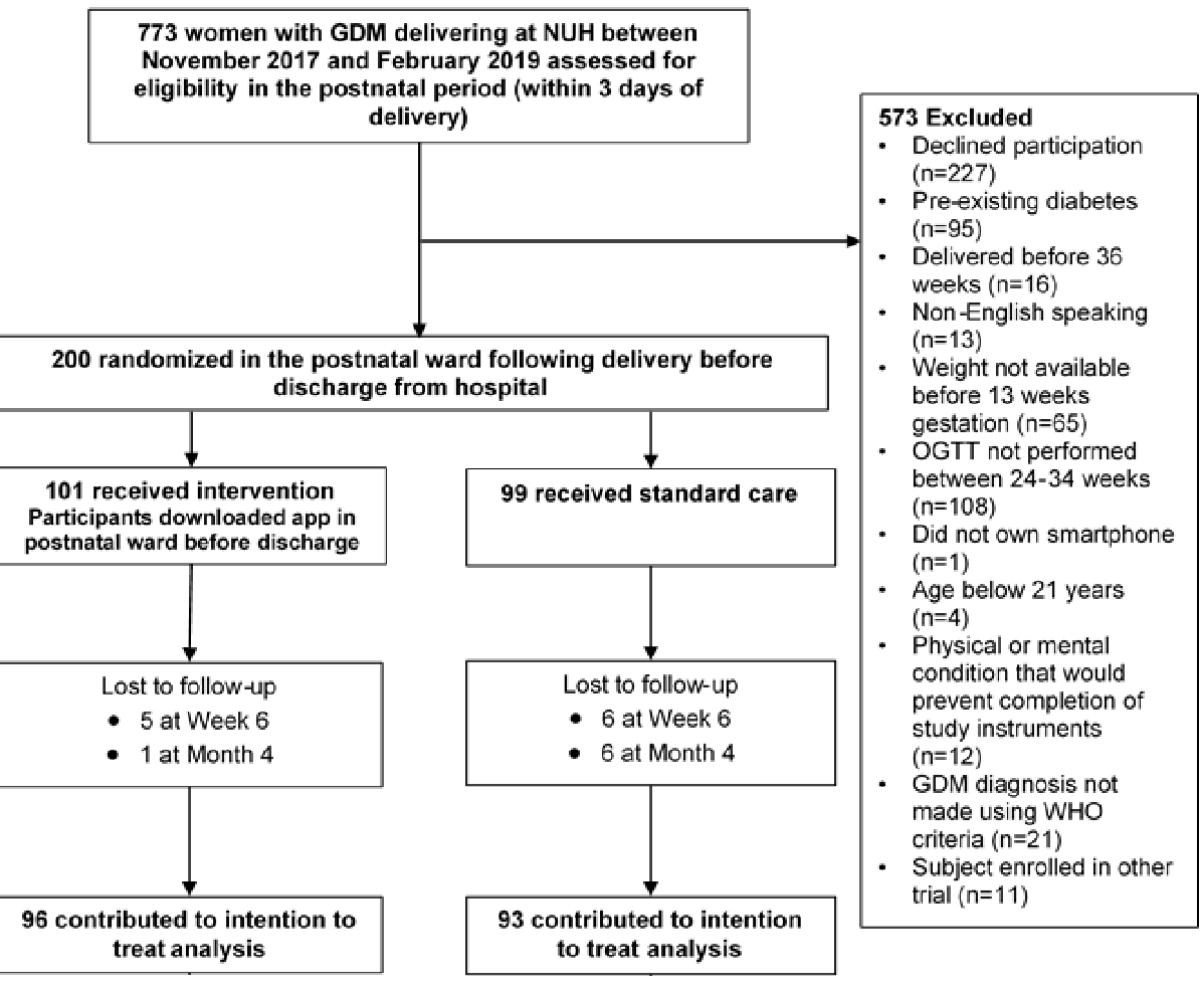
Figure 1. Trial flow. GDM: gestational diabetes mellitus; NUH: National University Hospital; OGTT: oral glucose tolerance test; WHO: World Health